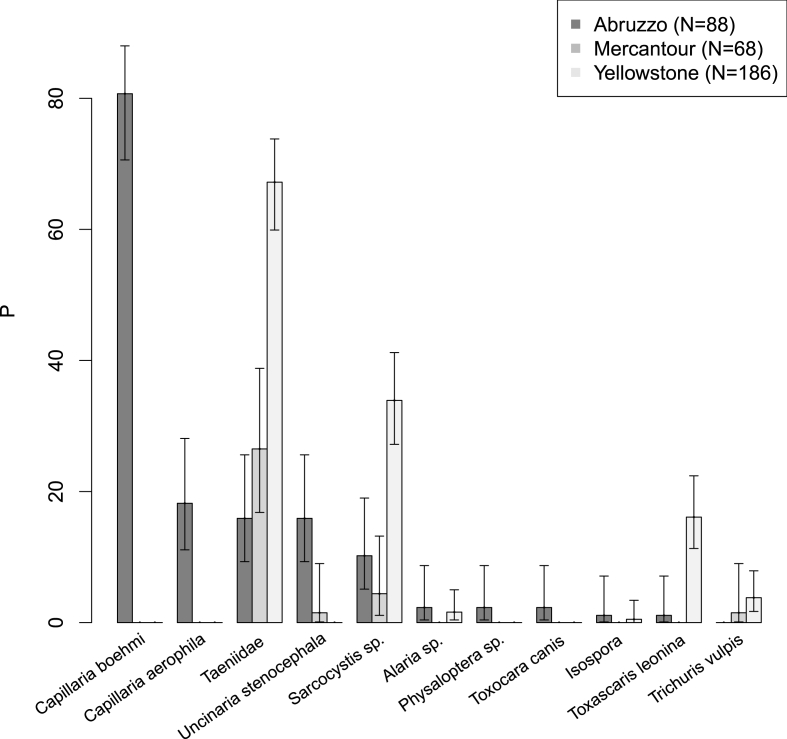
Canid endoparasites detected in faecal samples of three different wolf populations from PNALM (2006–2007), PNM (2006–2007), and YNP (2007–2009). The total number of analysed samples (N), the proportion (P) and corresponding 95% confidence intervals (CI) are specified. P and CI are expressed as percentages (%).